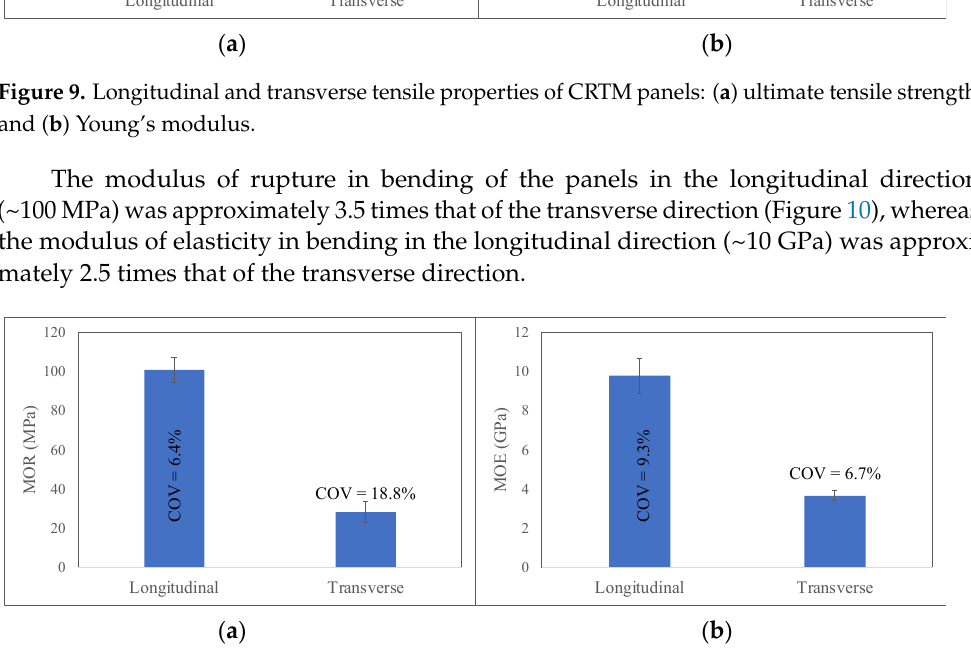
Figure 10. Longitudinal and transverse bending properties of CRTM panels: (a) modulus of rupture, and (b) modulus of elasticity.